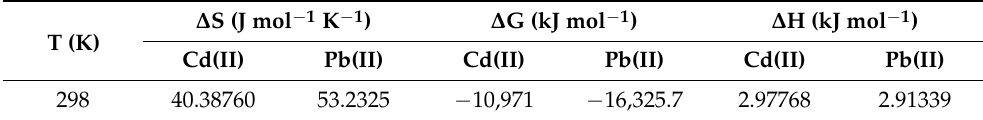
Table 5. Thermodynamic conditions for 50 mg/L Pb 2+ and Cd 2+ adsorption on BI@MWCNTs at 25 ◦ C.